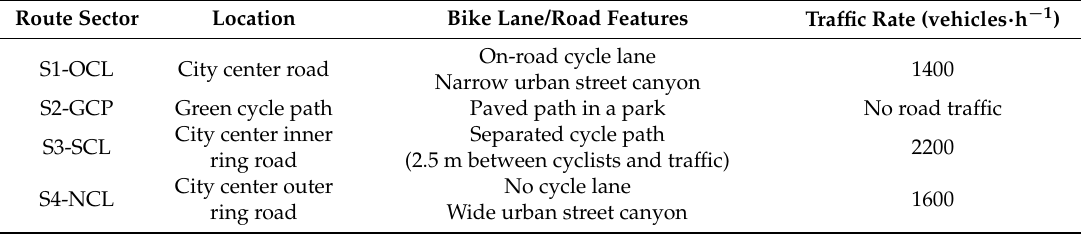
Table 1. Main features of the route sectors.